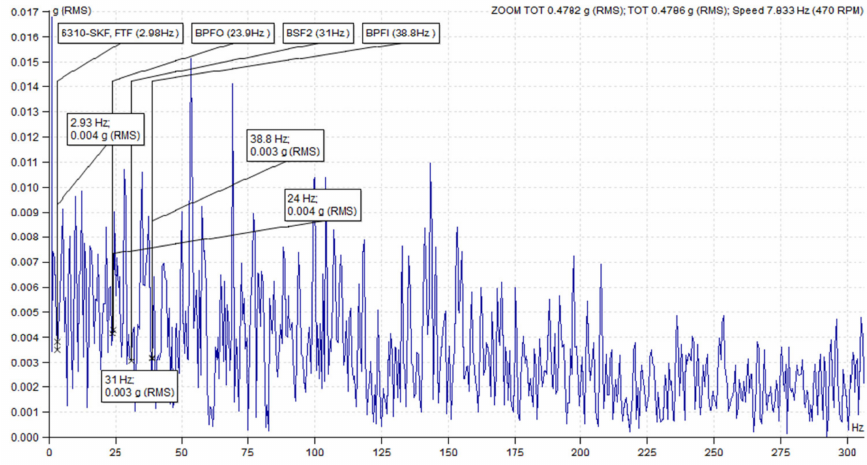
Figure 12. The fast Fourier transform (FFT) (500 Hz–16 kHz) demodulation of the 6310 SKF of the non- driving end of the threshing drum of Massey Ferguson 7370 Beta (New), a sensor mounted on housing.